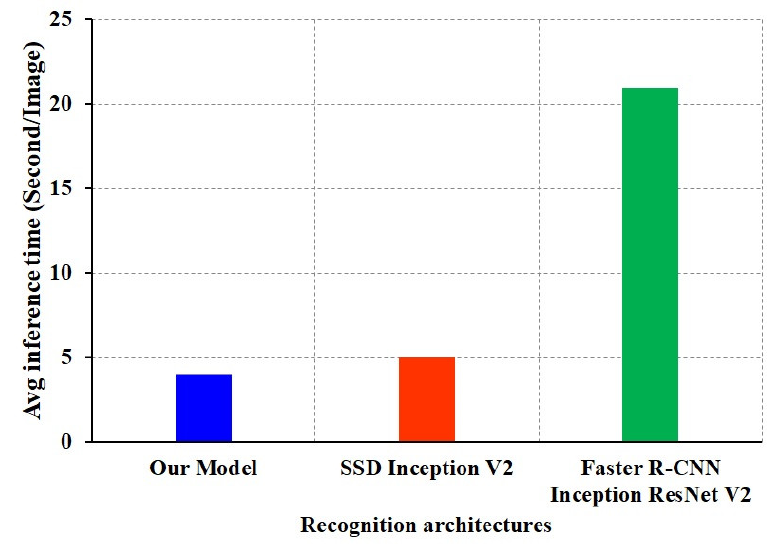
Figure 5. Inference time